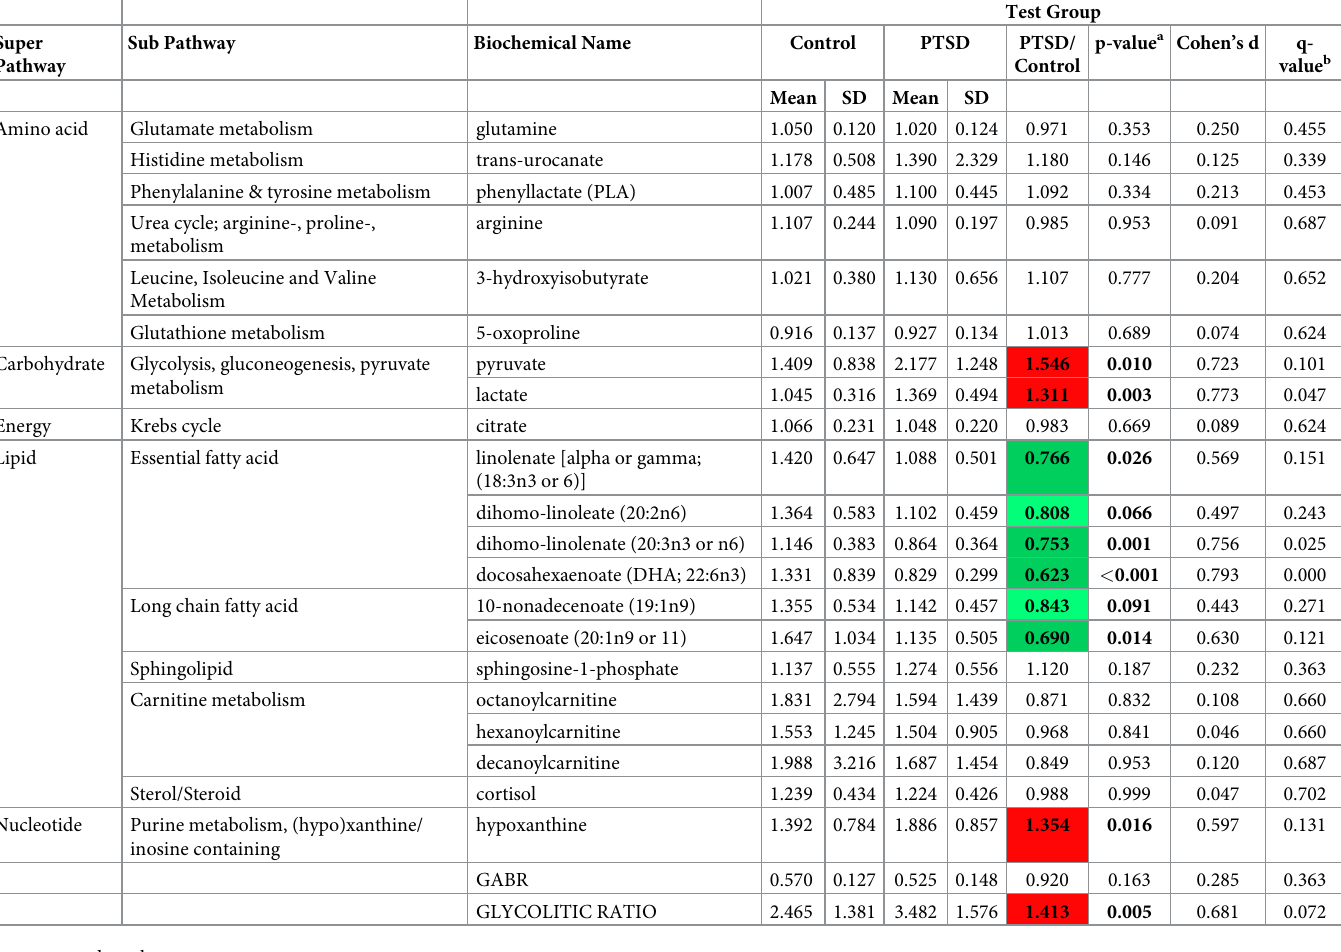
Table 3. Test group validation of biochemicals that achieved statistical significance (p < 0.05) between groups of male combat veterans with and without PTSD in the Discovery group.